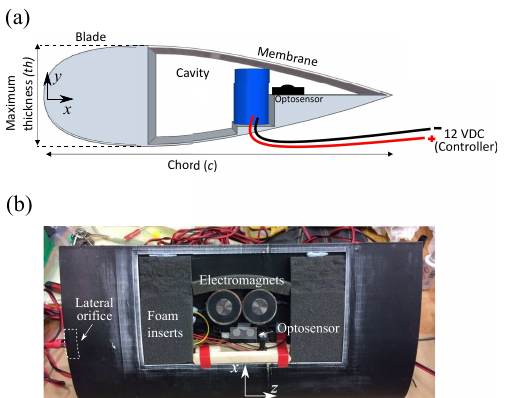
Figure 1. ( a ) Side view of blade cross section, with cavity covered by the membrane, ( b ) Top view of final assembly with cavity, electromagnets, optosensor, supporting foams and wooden